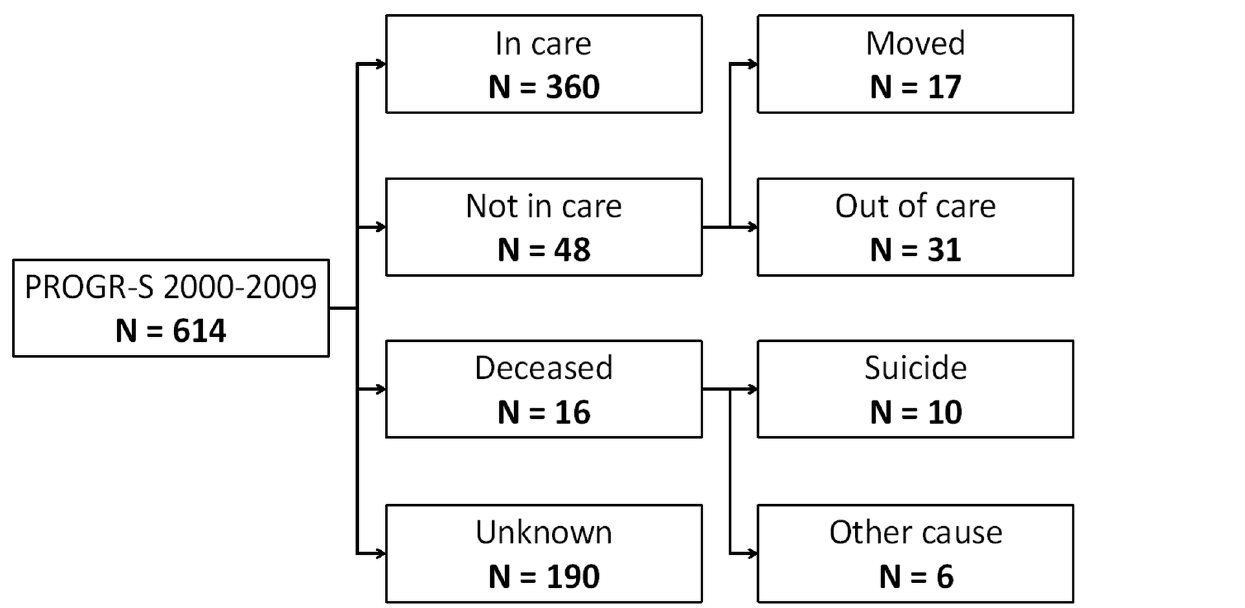
Fig 1. Flow diagram of patient status at July 2011, the unknown group was lost to follow up and not included in analysis.